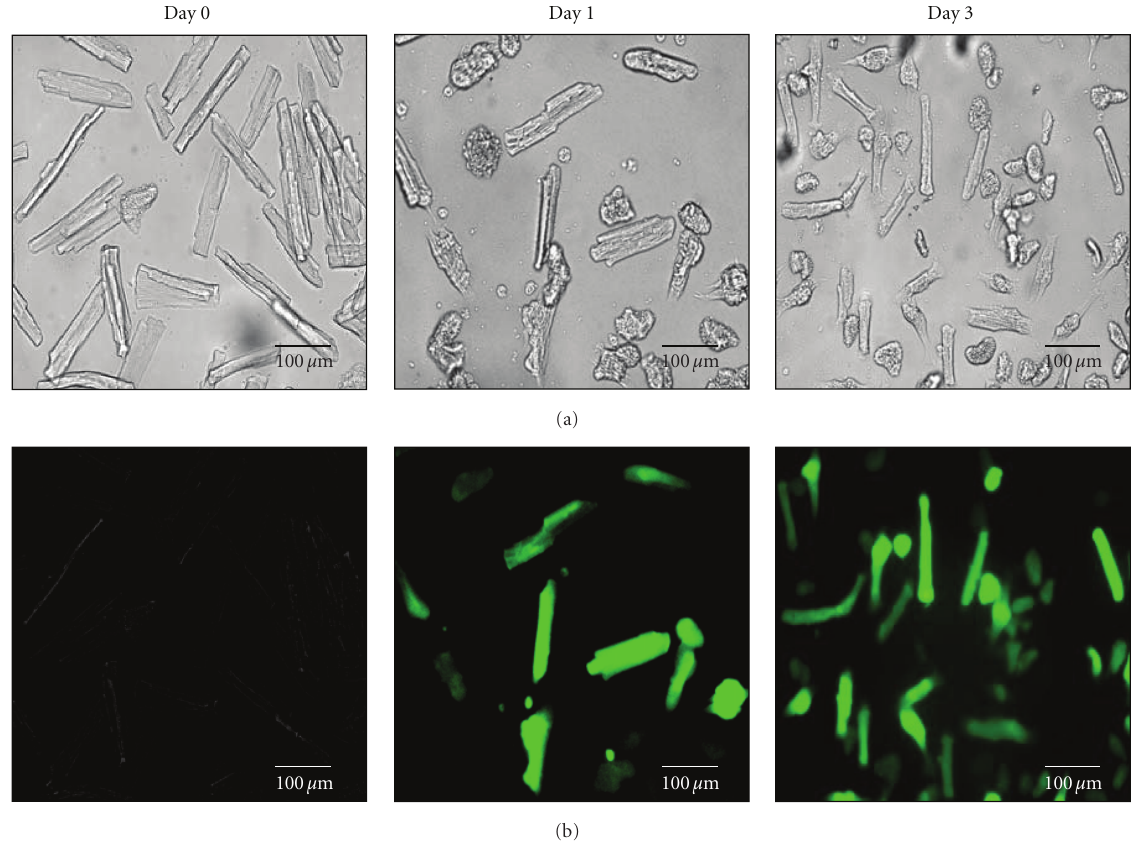
Figure 3: (a) Representative light and (b) fluorescent microscopic images of cell culture, before and after 1 day and 3 days of virus infection. Expression of recombinant pseudorabies-viral troponeon transgenes appeared on high level in cultured adult dog ventricular myocytes. The isolation of adult dog left ventricular myocytes yielded more than 80% living cells. After three days the troponeon expression and the physiological features of survival myocytes was appropriate for the physiological